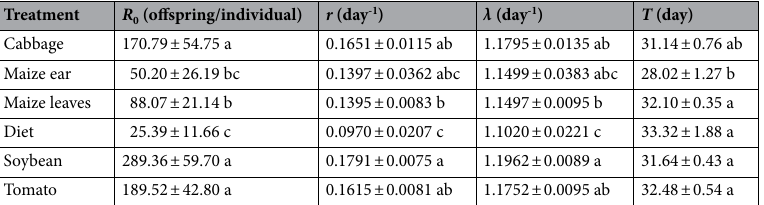
Table 4. Mean (± SE) of the net reproductive rate ( R 0 ), intrinsic rate of increase ( r ), finite rate ( λ ), and mean generation time ( T ) of the fall armyworm, Spodoptera frugiperda fed on cabbage, maize ear, maize leaves, artificial diet, soybean, and tomato. Standard errors were estimated using 100,000 bootstrap resampling. Data followed by the same lower-case letter within a column were not significantly different based on a paired bootstrap test at 5% significance level.